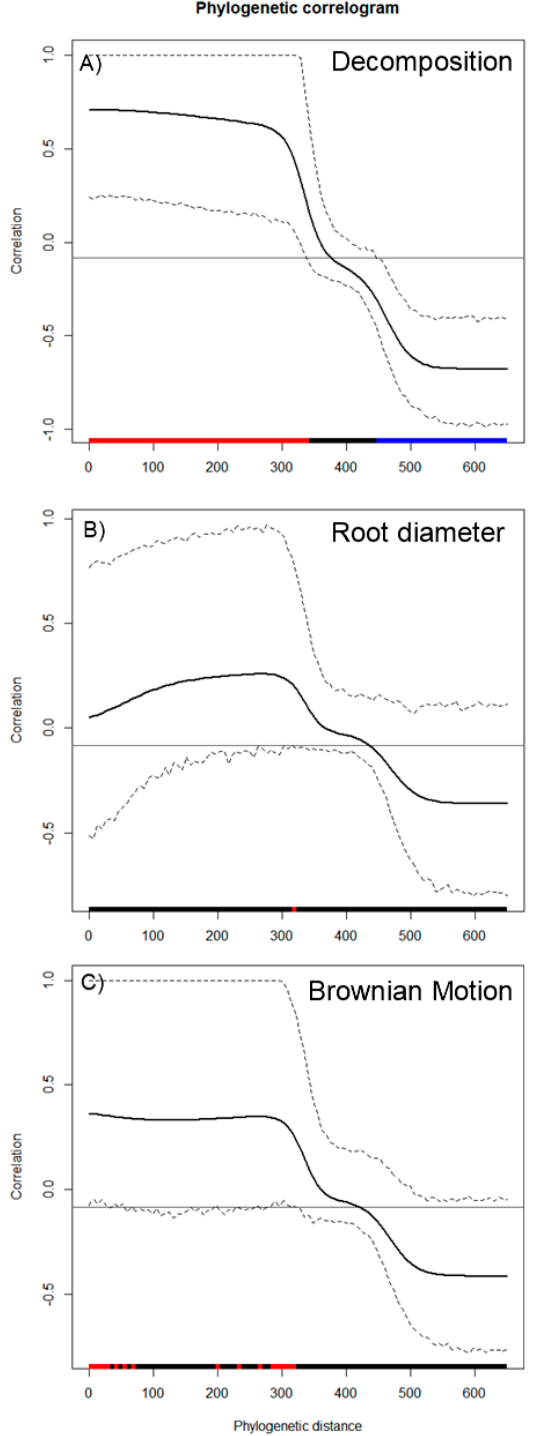
Figure 3. Phylogenetic correlograms for 3 traits: ( A ) decomposition, ( B ) root diameter, and ( C ) Brownian motion model. Here, correlations (y-axis) are assessed with respect to phylogenetic distance (x-axis). Red bars along the x-axis indicate significant positive autocorrelation, while blue bars along the x-axis indicate significant negative autocorrelation. With respect to the plotted lines, the solid black line represents Moran’s I index of autocorrelation. Hashed lines represent the upper and lower bounds of 95% CI.